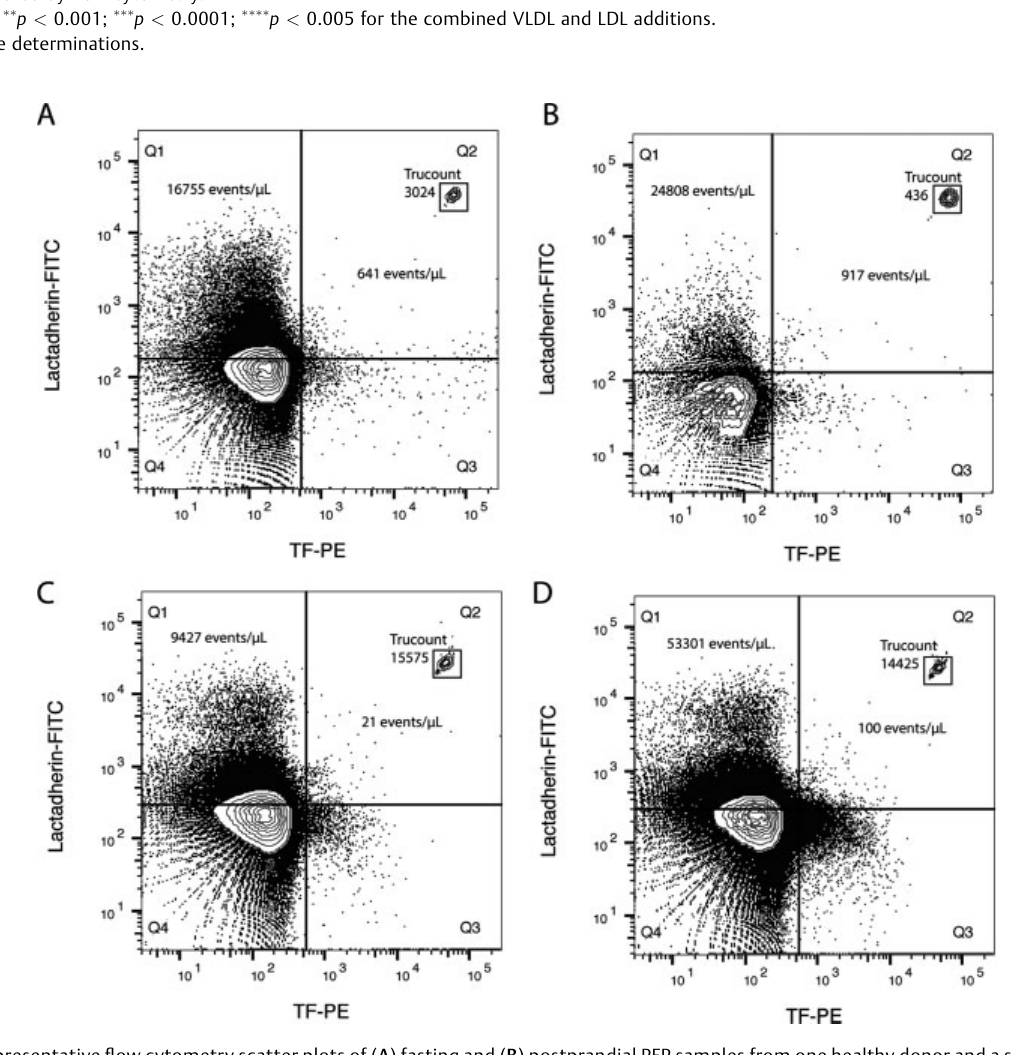
Fig. 3 Representative fl ow cytometry scatter plots of ( A ) fasting and ( B ) postprandial PFP samples from one healthy donor and a sample before ( C ) and after ( D ) addition of VLDL. The number of TruCount beads and the number of TF (cid:2) PS þ and TF þ PS þ particles are given in quadrant 1 (Q1) and 2 (Q2), respectively. Increased particle numbers lead to a higher coincident rate. Flow rates were, therefore, adjusted in postprandial samples with many events to maintain event rates below the maximal fl ow rate limit ( < 20,000 events/second) and thereby reduce coincident detection. Note: A lower fl ow rate reduces both the numbers of TruCount beads (the framed dots in quadrant 2) and PS þ events acquired in the postprandial scatter plot ( B